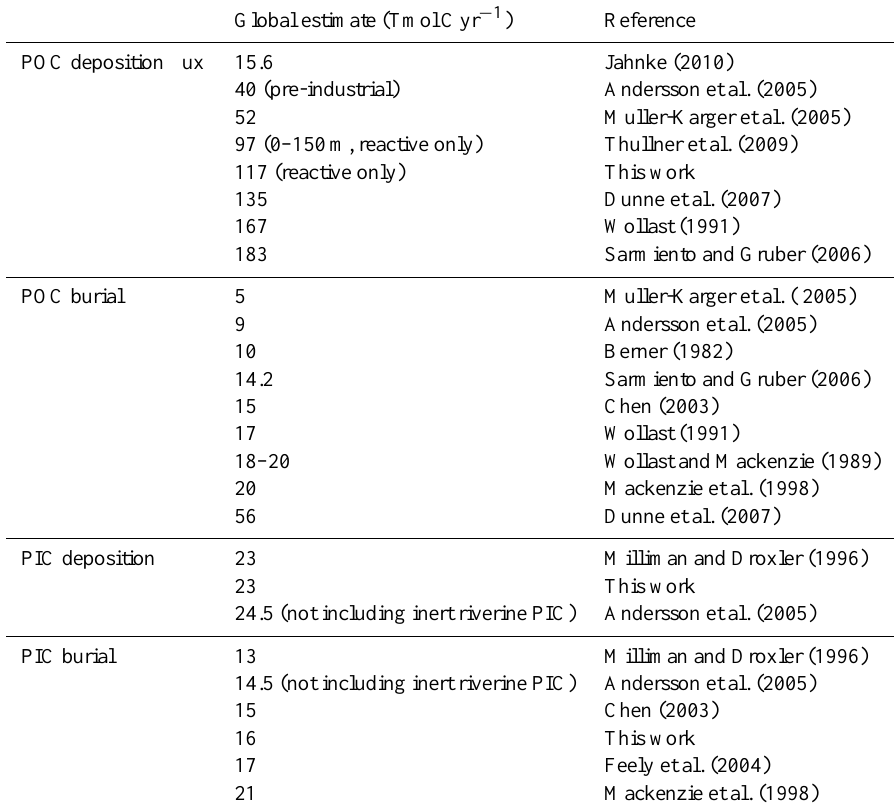
Table 1. Global C flux estimates in coastal